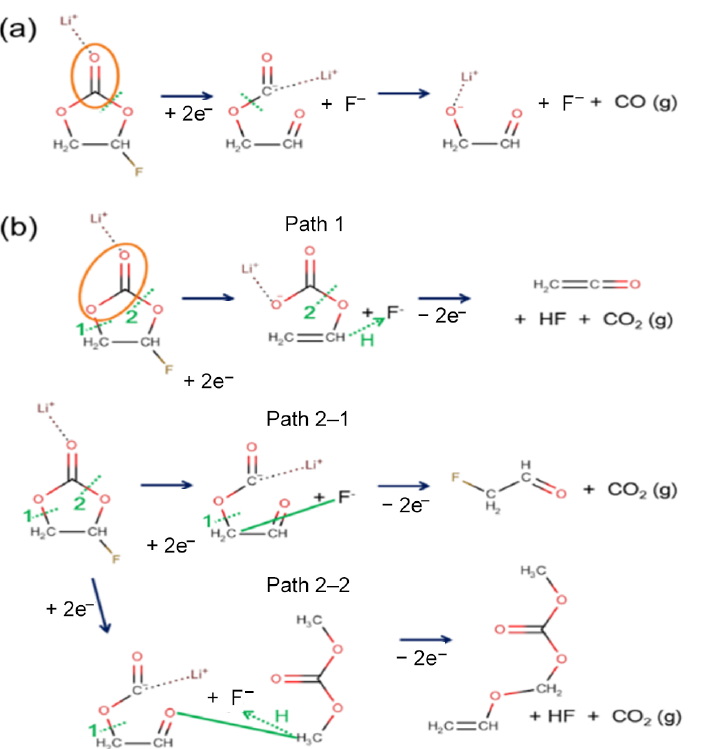
Figure 3. Reaction mechanism of ( a ) CO and ( b ) CO 2 gas generation out of FEC. CO gas molecules are generated mainly from electro-reductive reactions. However, CO 2 molecules are generated when reduced FEC goes through oxidative reactions. The dotted green line indicates the bond breaking, and the orange oval is the moiety that broke off to become gas molecules after the reaction. In addition, the solid green lines indicate the formation of the new bond. The dotted green line with an arrow shows the transfer of hydrogen